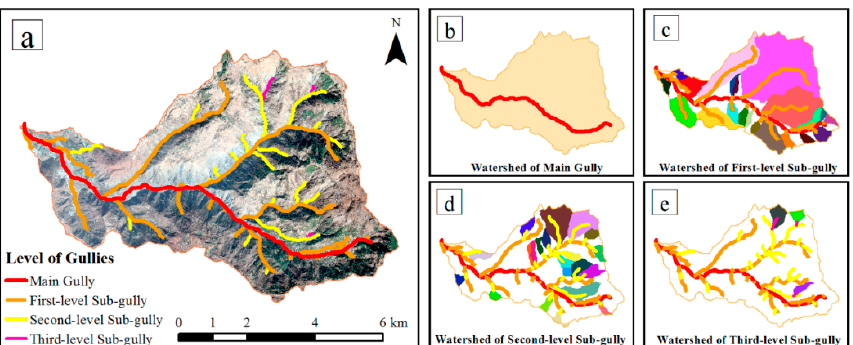
Figure 7. Division of main and sub-gullies in JJG and their confluence areas. ( a ) Main and sub-gullies; ( b ) Confluence area of the main gully; ( c ) Confluence area of the first-level sub-gully; ( d ) Confluence area of the second-level sub-gully; ( e ) Confluence area of the third-level sub-gully. The JJG includes 1 main gully, 21 first-level gullies, 21 second-level gullies and 3 third-level gullies.